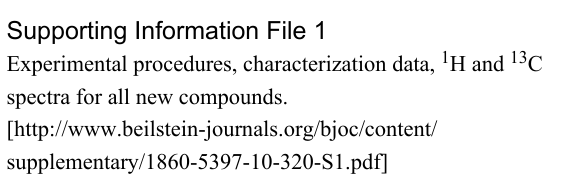
scalar nor dipolar coupling between NH and CH groups were detected in these experiments which would be expected for structure 6'a . The data obtained from the HMBC spectrum also unambiguously supported the connectivity of structure 6a and not those of structures 6'a or 6''a .